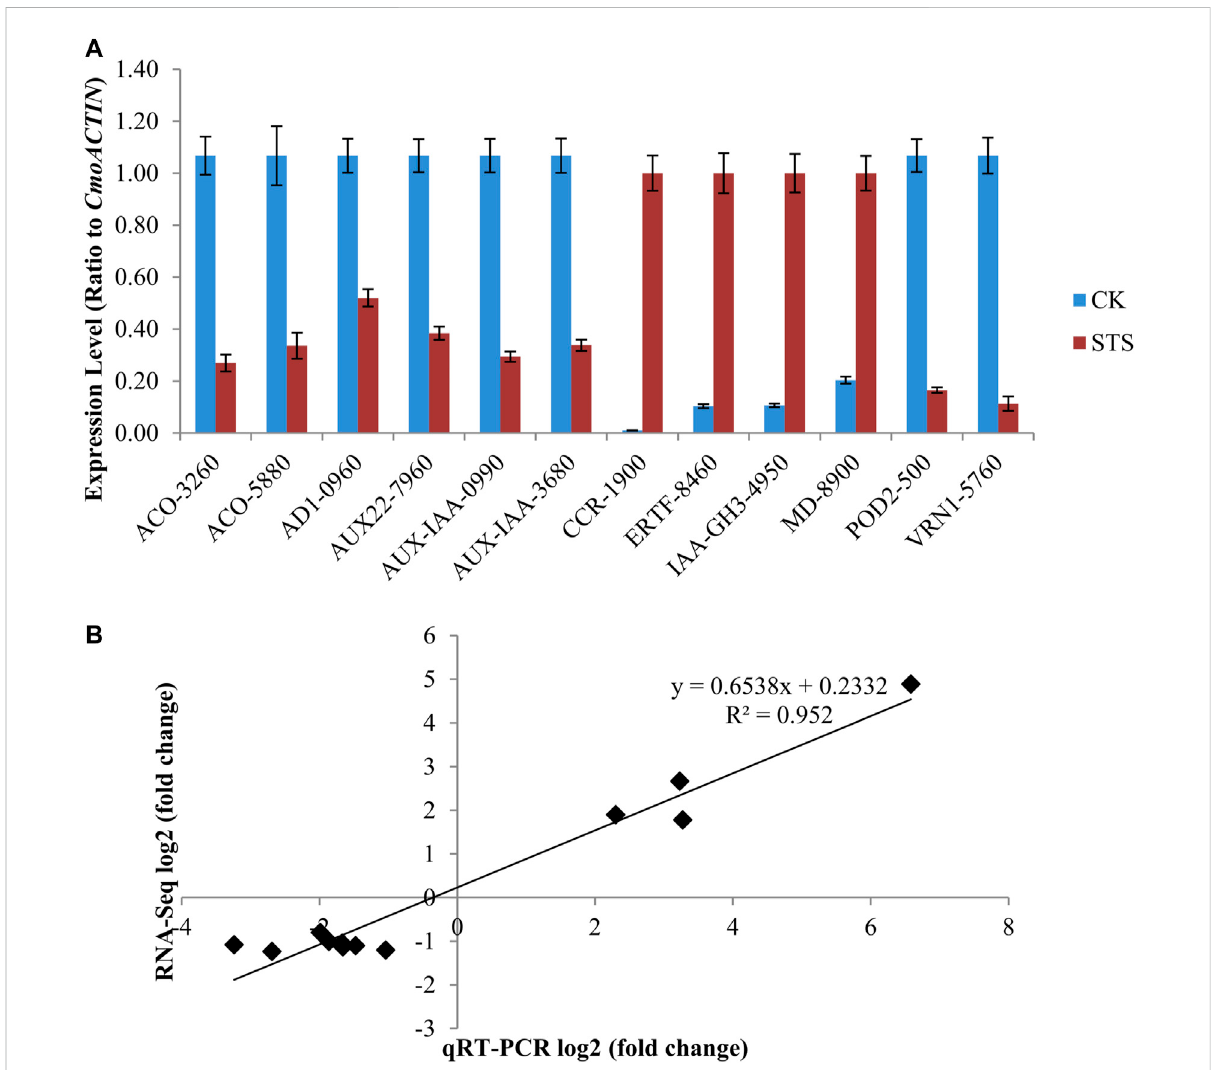
FIGURE 5 Comparison of the relative expression level change in 12 randomly selected differentially expressed genes (DEGs) by qRT-PCR and RNA-Seq. (A) Relative expression levels of genes in control and silver thiosulphate-treated plants. Values are the mean ± SE (standard error). (B) Correlation analysis of qRT-PCR log 2 (fold-change) and RNA-Seq log 2 (fold-change) values of the selected DEGs. ACO-5880 (CmoCh03G005880), AD1-0960 (CmoCh09G010960), AUX22-7960 (CmoCh17G007960), AUX-IAA-0990 (CmoCh07G010990), AUX-IAA-3680 (CmoCh03G003680), CCR-